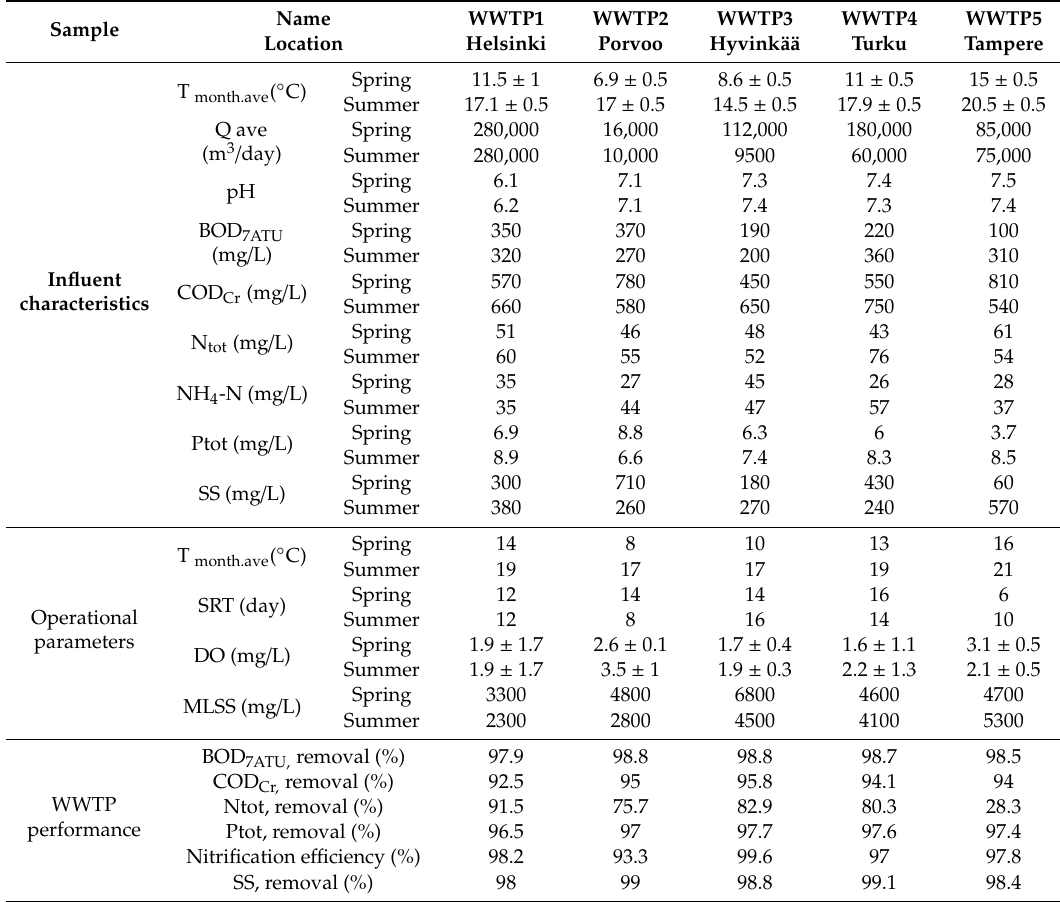
Table 1. General characteristics of studied wastewater treatment plants